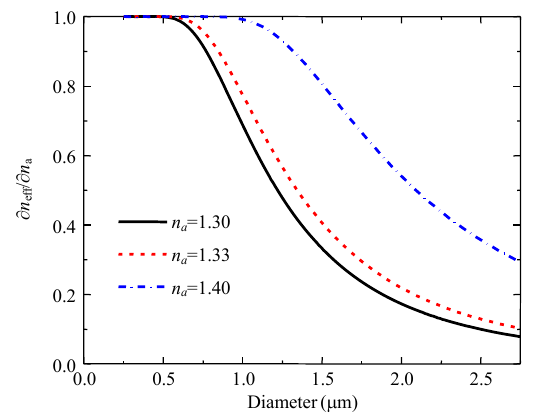
Fig. 8 Effective sensitivity of a phase-based silica microfiber sensor as a function of diameter for different surrounding refractive indices at a wavelength of 1 550